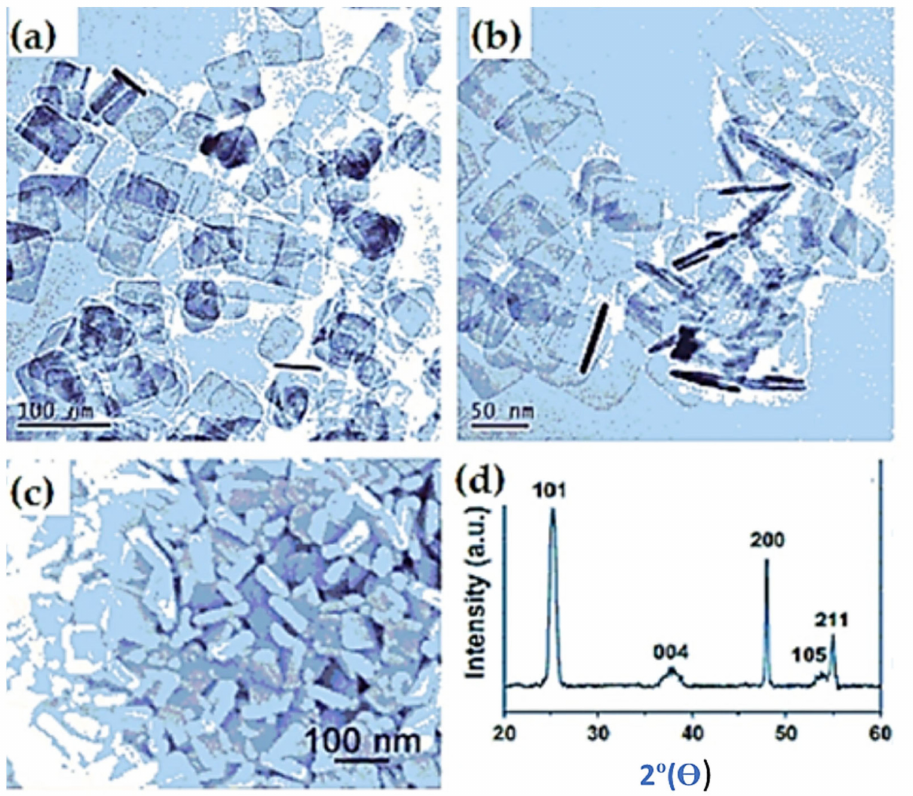
Figure 12. ( a , b ) TEM images, ( c ) HRTEM image, and ( d ) XRD pattern of the TiO 2 nanosheets. Reprinted with permission from Ref. [78]. Copyright 2009